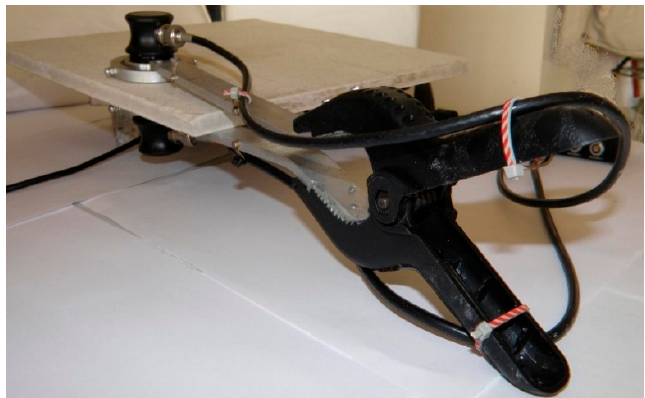
Figure 3. Detailed view of the custom-designed holder for correct coupling between the ultrasonic transducers and both sides of the rough surface board.